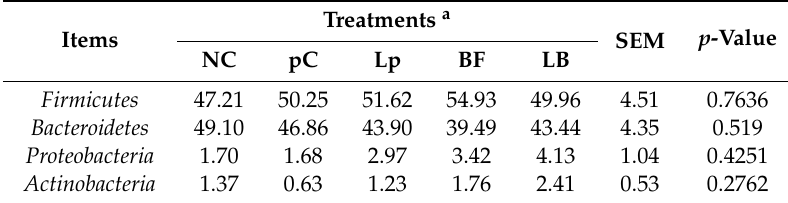
Figure 3. Effects of L. plantarum , tartary buckwheat flavones and their combination compared to the dominant bacterial phyla. The color-coded bar plot shows the relative abundances of different genera across different groups. Table 5. Effects of L. plantarum , tartary buckwheat flavones, and their combination on comparison of the dominant genus of microbes.